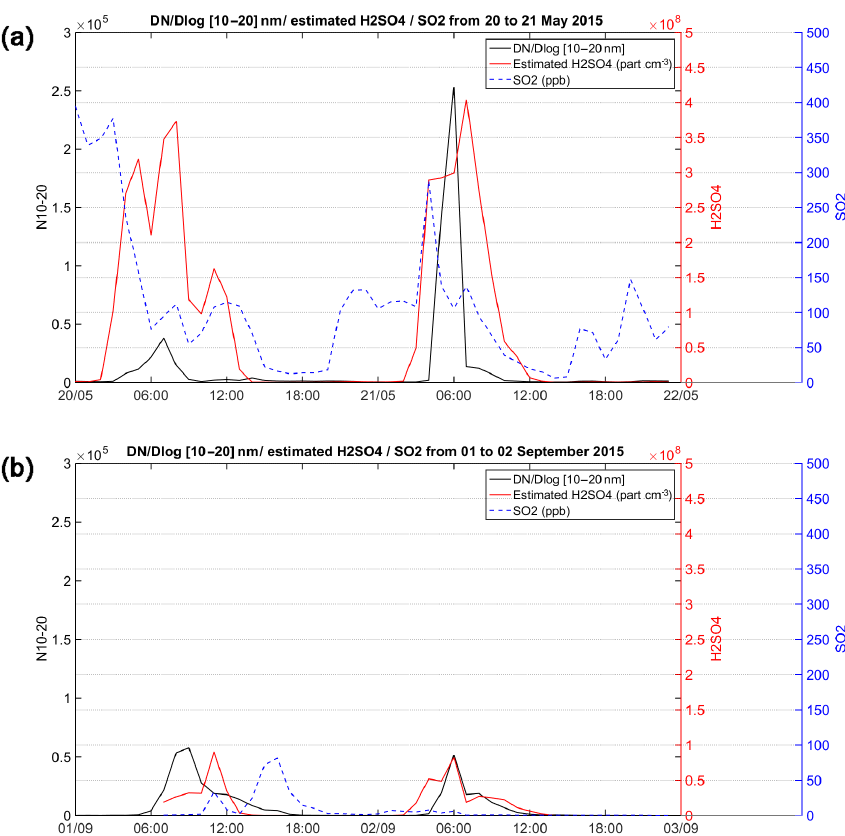
Figure 15. Time series of the 10–20nm particle concentrations (black), SO 2 mixing ratio (ppb in blue) and H 2 SO 4 concentration estimated by proxy (cm − 3 in red) on 20–21 May 2015 (a) and on 1–2 September 2015 (b)